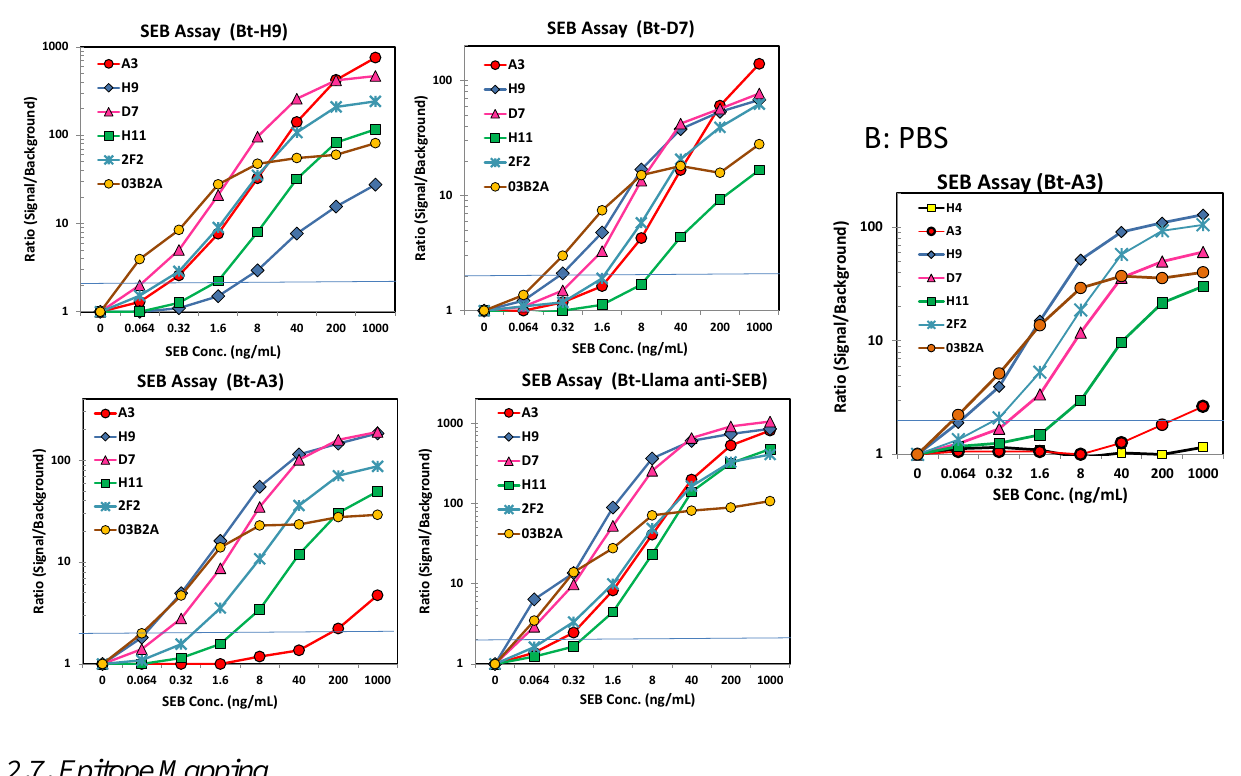
Figure 5. Sandwich-format MagPlex assay in milk. Capture beads contained each of the Abs cross-linked onto the surface as indicated. SEB was added at the concentrations shown followed by biotinylated (Bt) tracer Abs. Fluorescence detection carried out after addition of streptavidin-phycoerythrin. The error (SEM) was less than 10% for all values (not shown). B: MagPlex assay in PBS including a non-SEB binding sdAb capture set